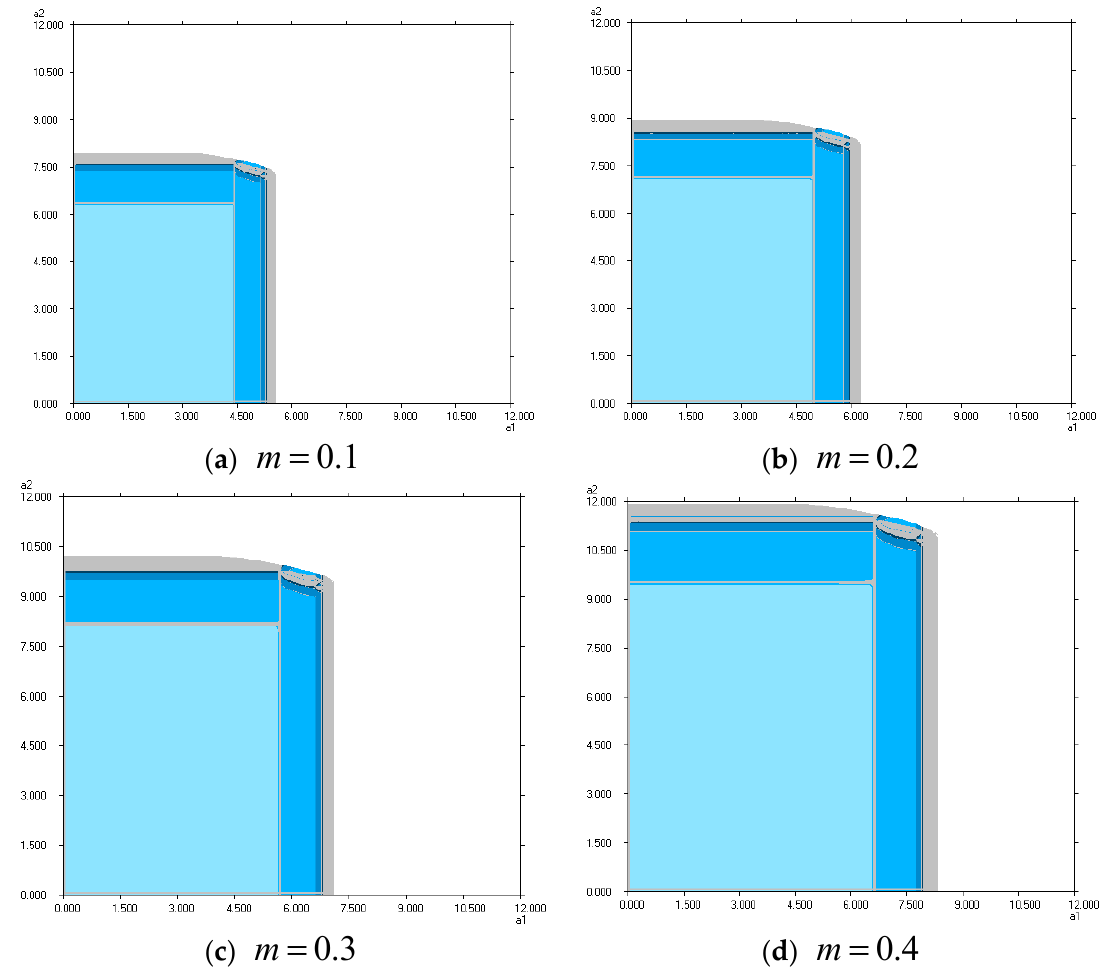
α α and with different m . Figure 18. The 2D bifurcation diagrams with respect to α 1 and α 2 with different m 1 2